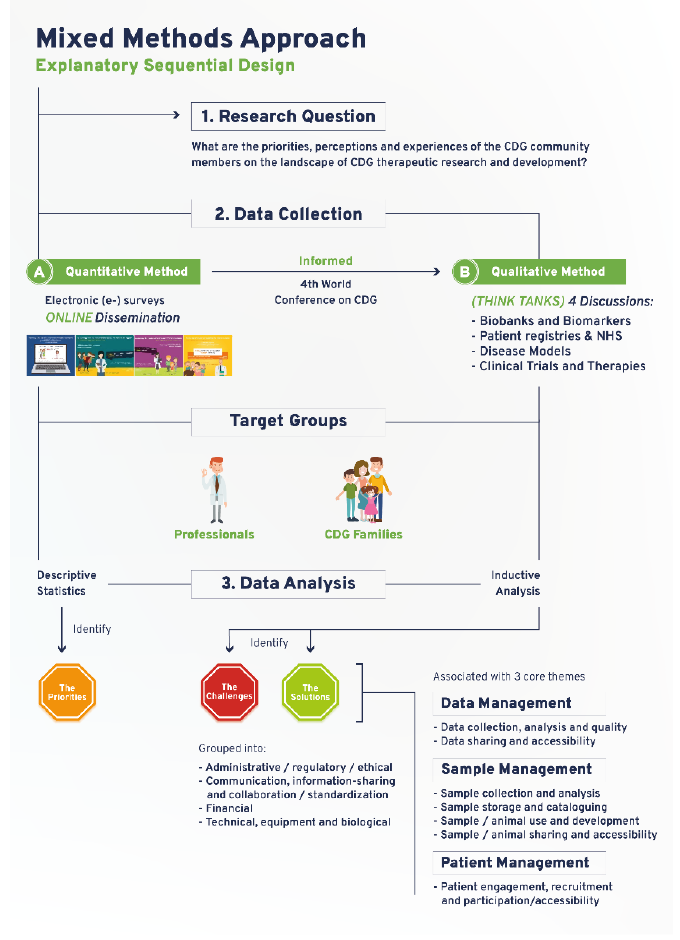
Figure 1. Schematic depiction of the devised and adopted explanatory sequential mixed methods research approach.